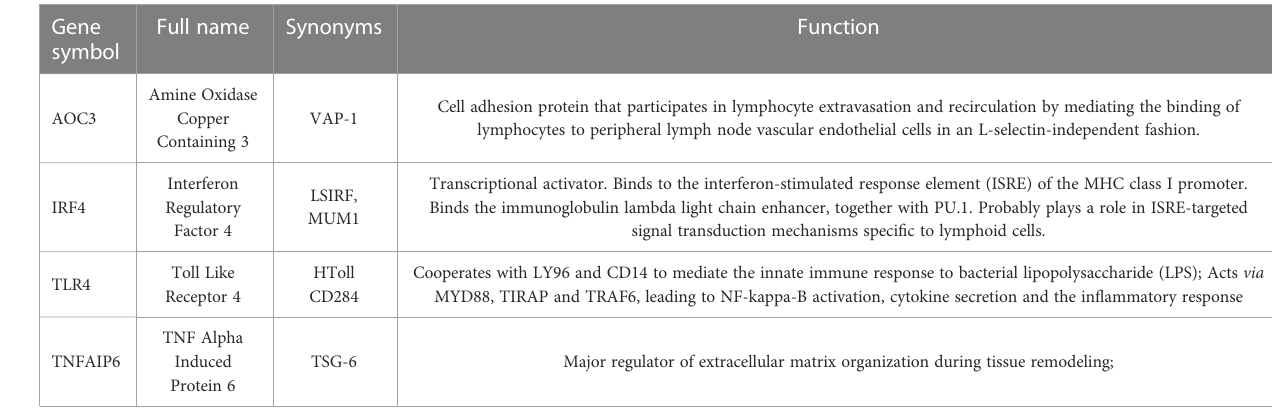
TABLE 3 Information for the hub